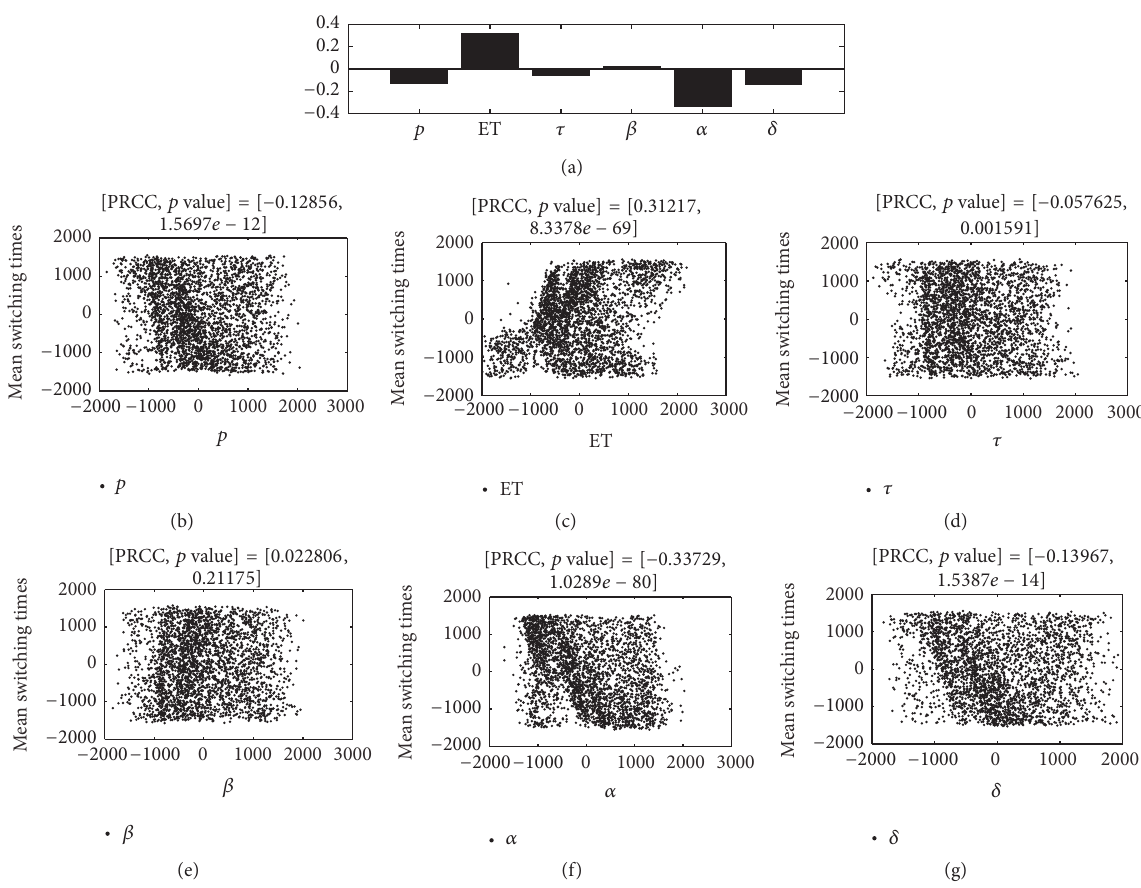
Figure 8: PRCC results and PRCC scatter plots. The baseline parameters are fixed as follows: 𝑝 = 0.2, 𝜏 = 0.2, 𝛽 = 4 , and 𝛿 = 2.0 , Here we fix 𝜎 = 0.25 ; initial density of prey and predator (𝑥 0 , 𝑦 0 ) = (0.2, 0.2) . (a) PRCC results. (b–g) PRCC scatter plots. The title of each plot represents the PRCC value with the corresponding 𝑝